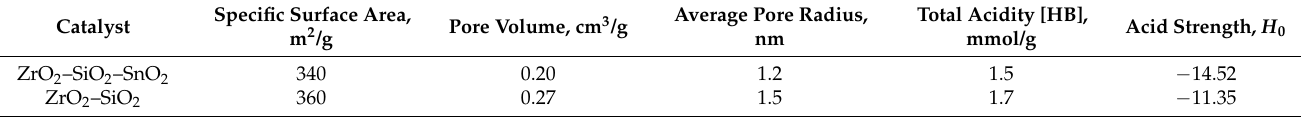
Table 1. Texture and acid parameters of the synthesized